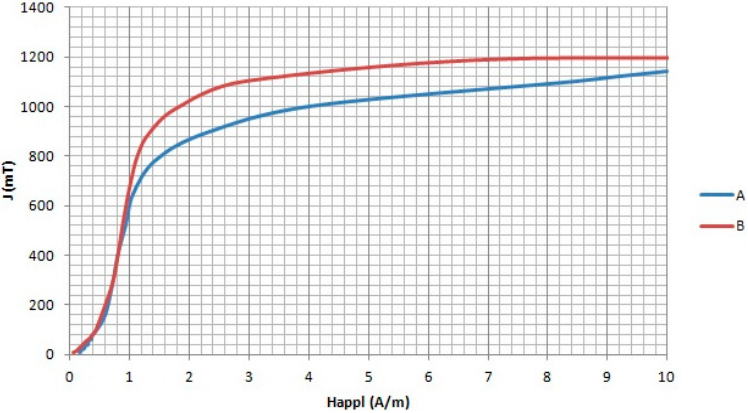
Figure 5. Virgin magnetization curve of the two nanocrystalline magnetic cores.